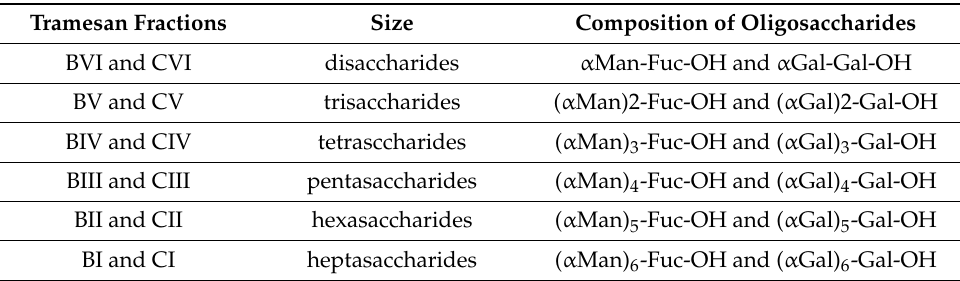
Table 2. Oligosaccharides present in each B and C fraction of the hydrolyzed Tramesan © .